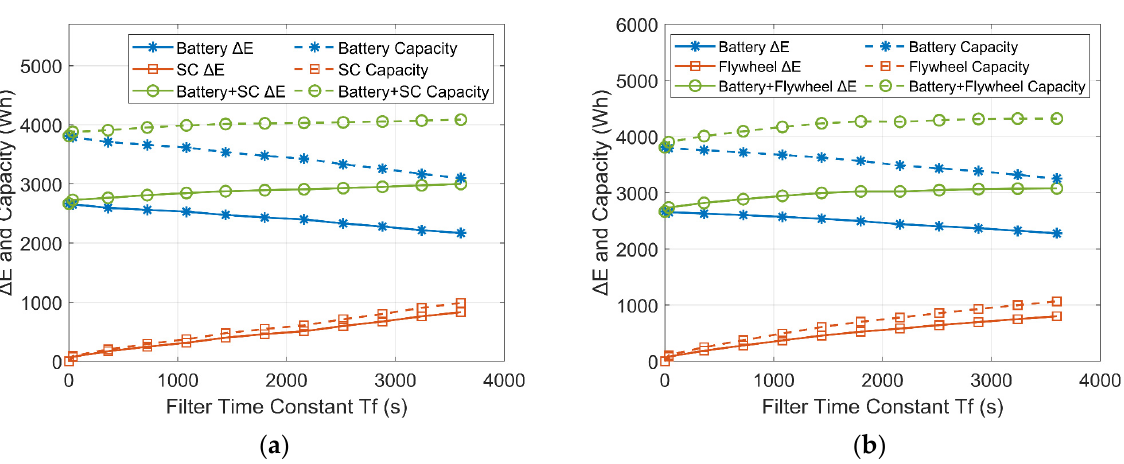
Figure 18. Variations of Δ E and capacities of the ESDs with increasing T f in a wind-powered household-prosumer system. ( a ) Battery-SC HESS. ( b ) Battery-flywheel HESS.